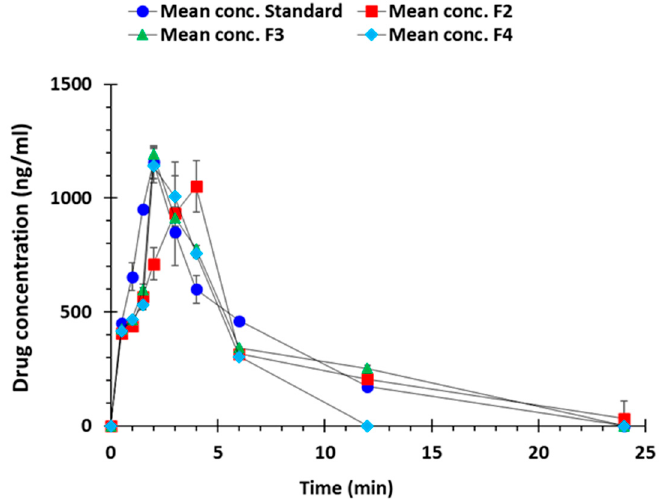
Figure 9. Drug absorption vs. time profiles of standard, F2, F3, and F4, 3D printed captopril tablets (n = 3).